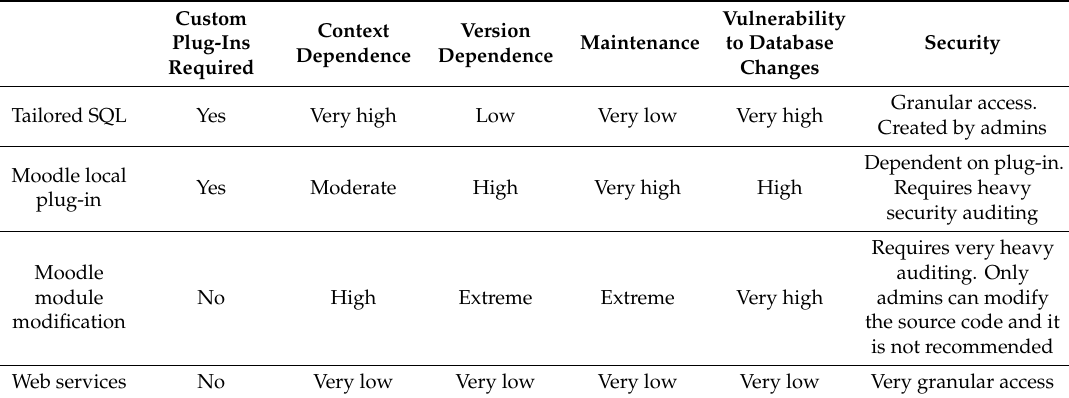
Table 2. Comparison of design choices for data extraction of peer assessment in